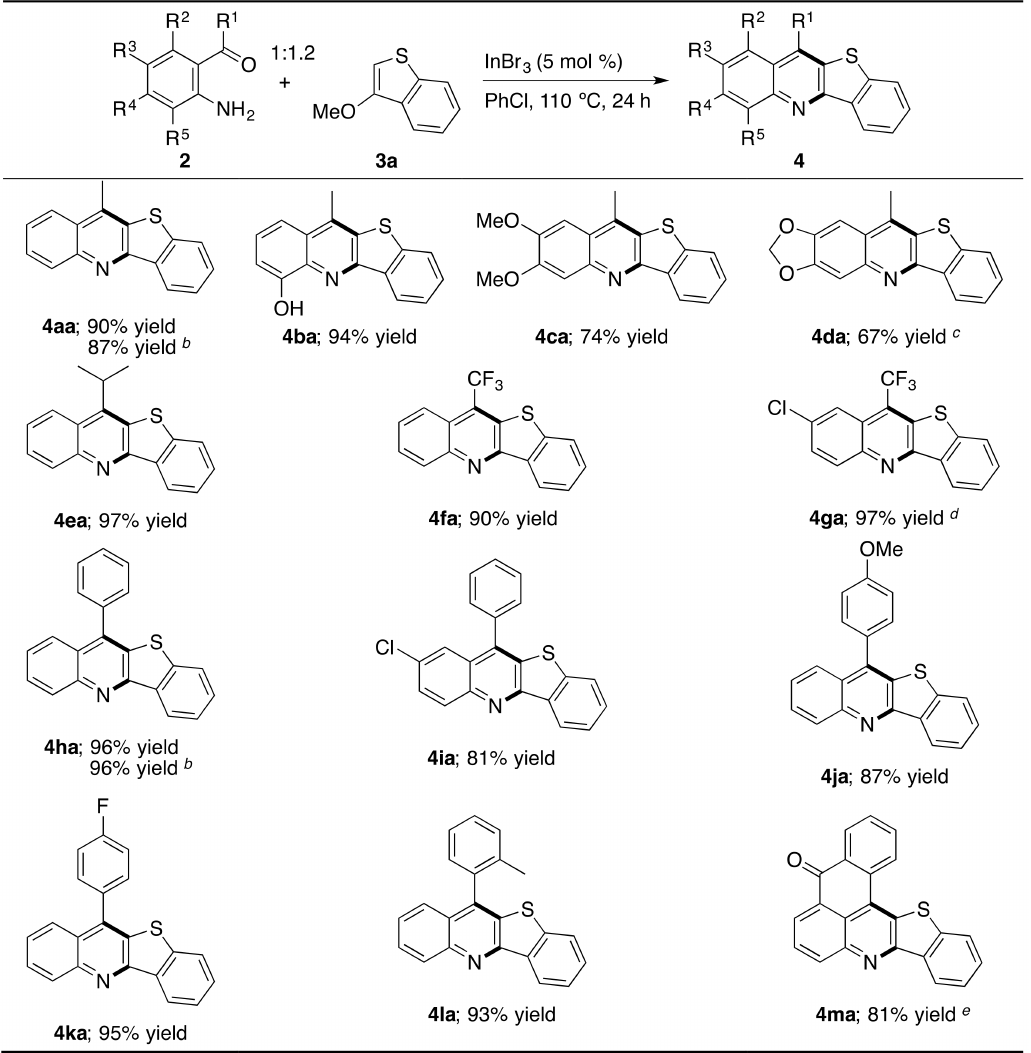
Table 3. Indium-catalyzed annulation of o -acylanilines with 3-methoxybenzothiophene a